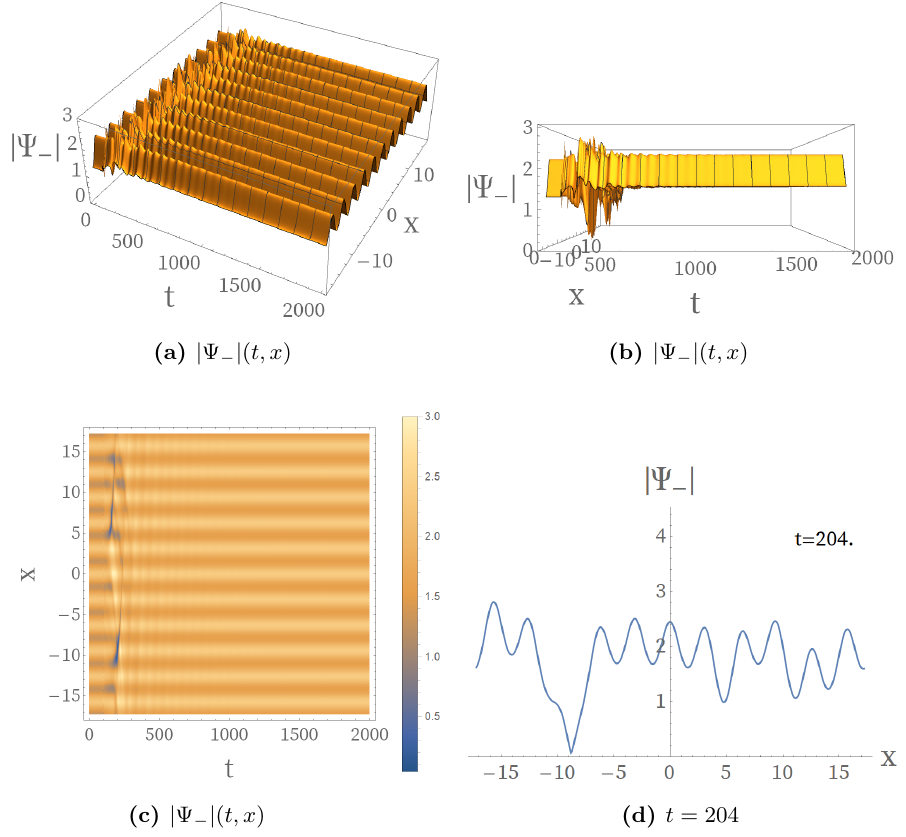
Figure 8. Evolution of the condensate | Ψ − ( t, x ) | with t ∈ [0 , 2000] of the unstable superflow k = 0 . 75 . The perturbation is given at t = 100 ; after that there are some solitons generated, as plotted in figure